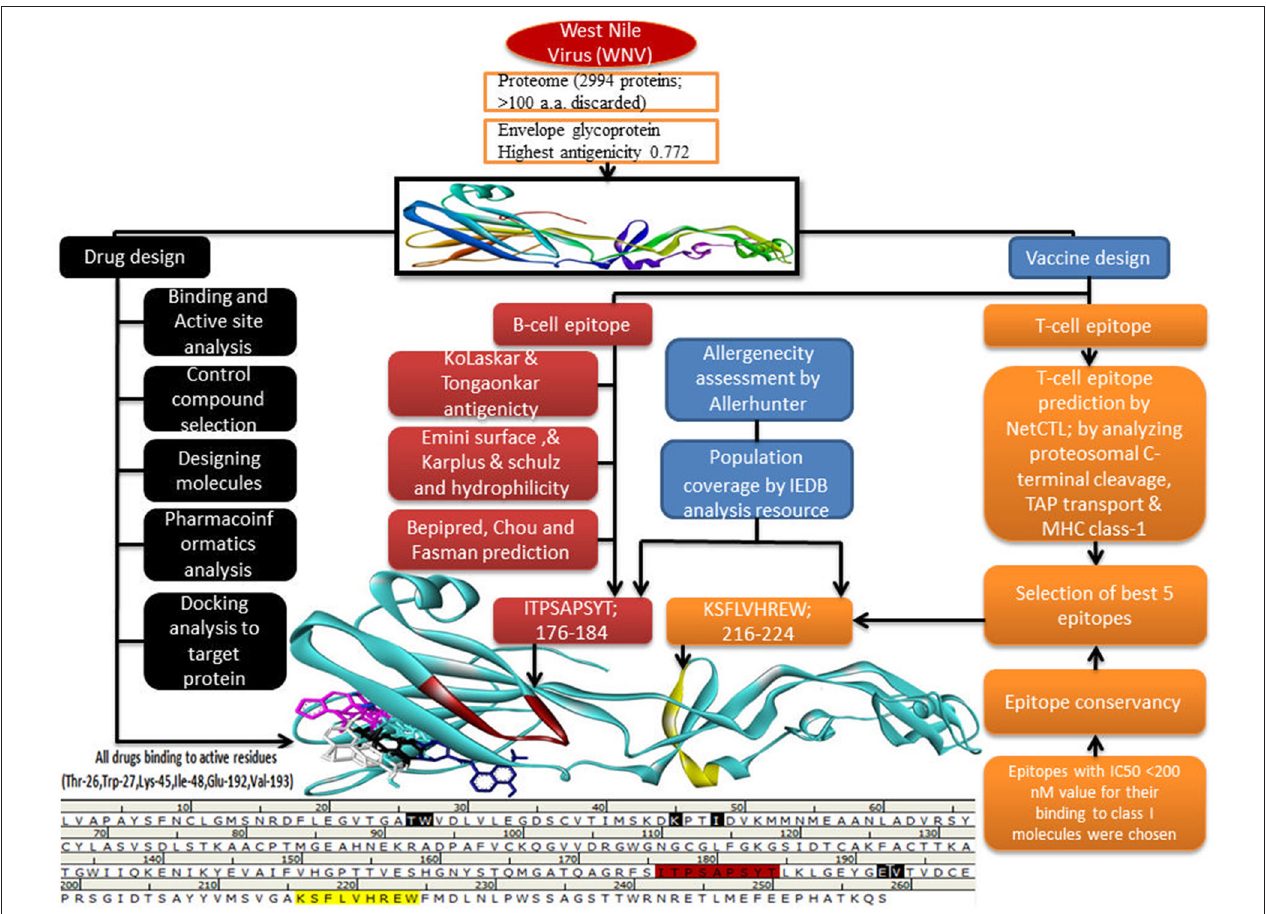
FIGURE 1 | Graphical outline of the current